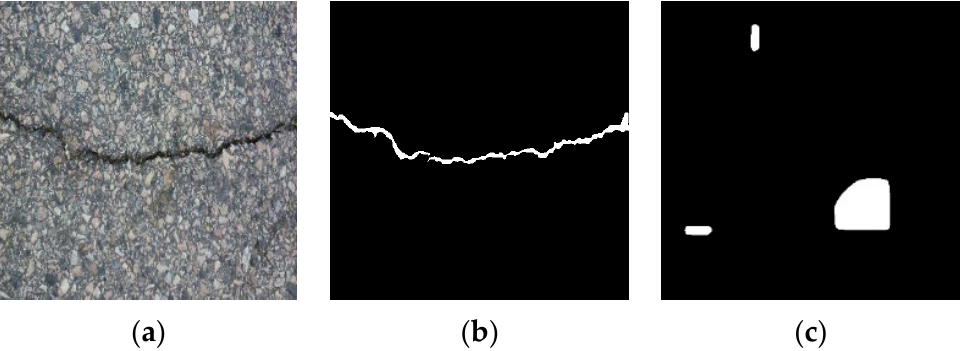
Figure 15. ( a ) Input RGB image; ( b ) ground truth for the input image; and ( c ) dead segmentation image produced by Rednet-50.